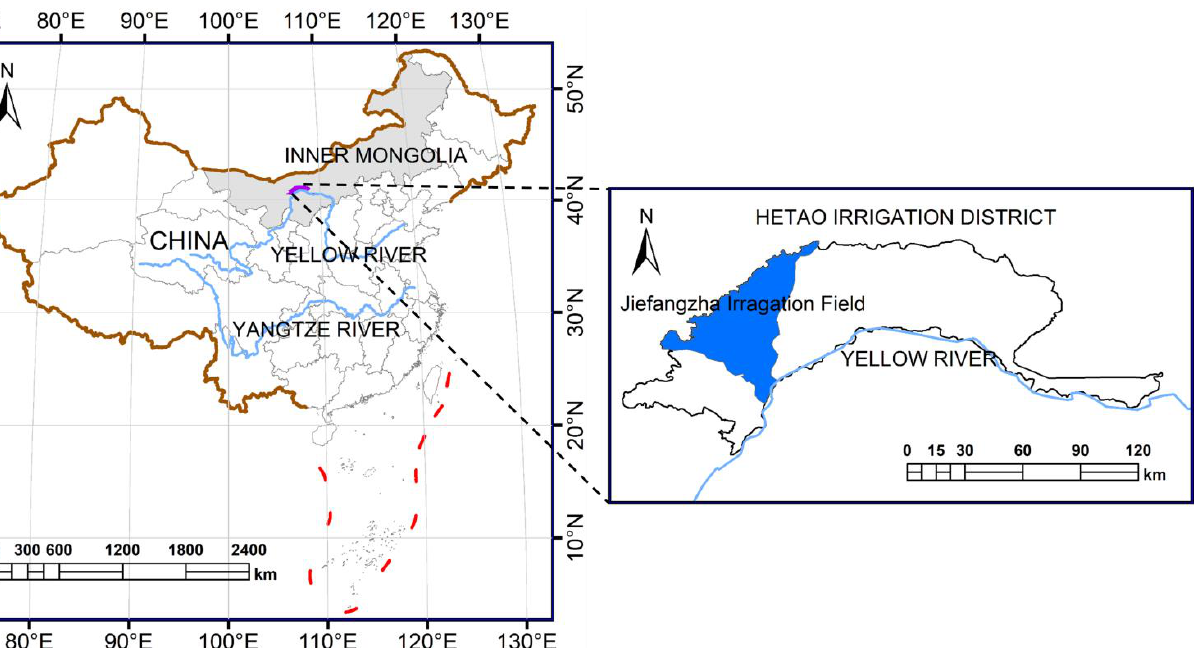
Table 1. Basic information about the meteorological stations.